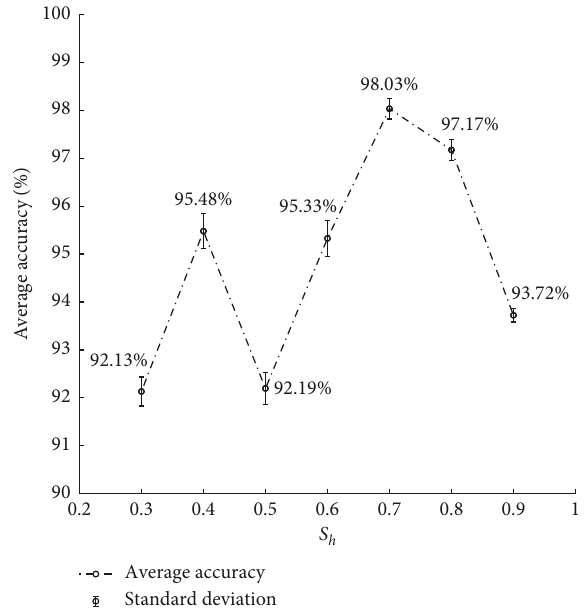
Figure 10: the average accuracy corresponding to the different sparsity S h ( r � 25).